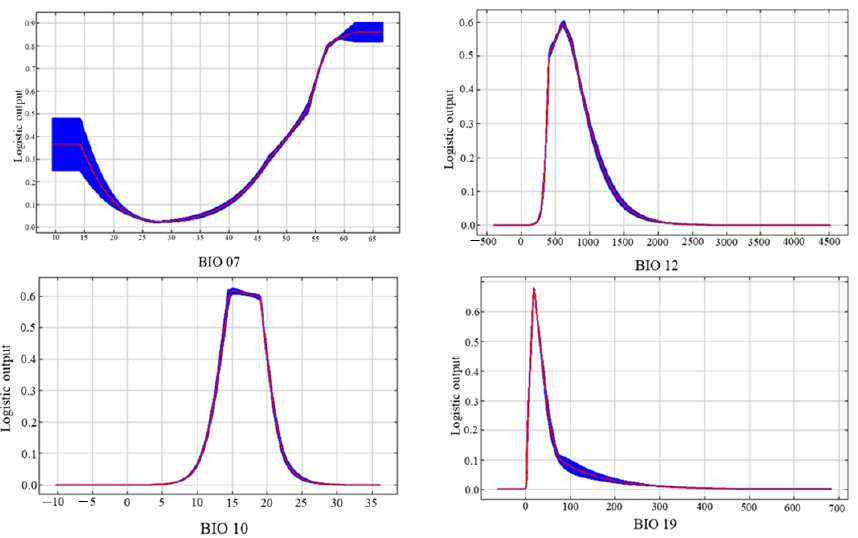
Figure 4. Response curves between the occurrence probability of V. uliginosum and environmental variables.